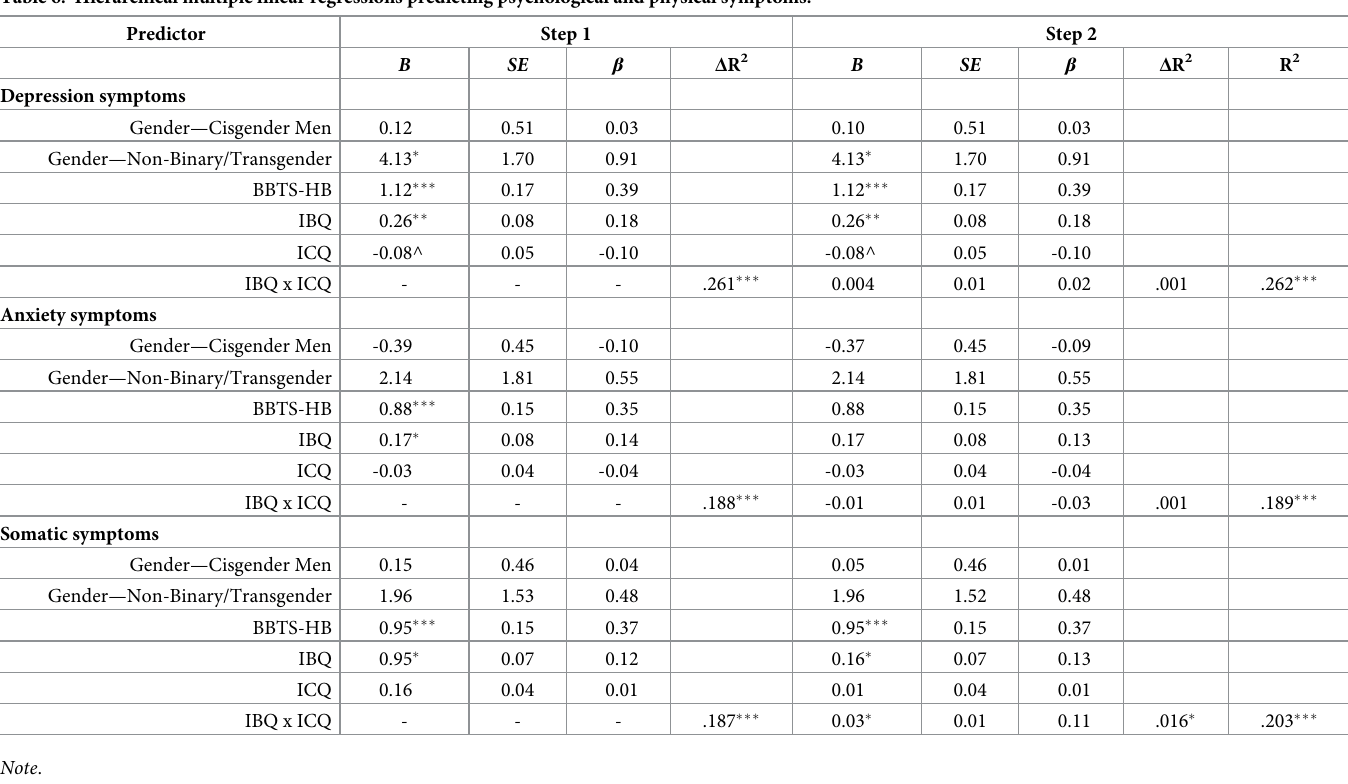
Table 6. Hierarchical multiple linear regressions predicting psychological and physical